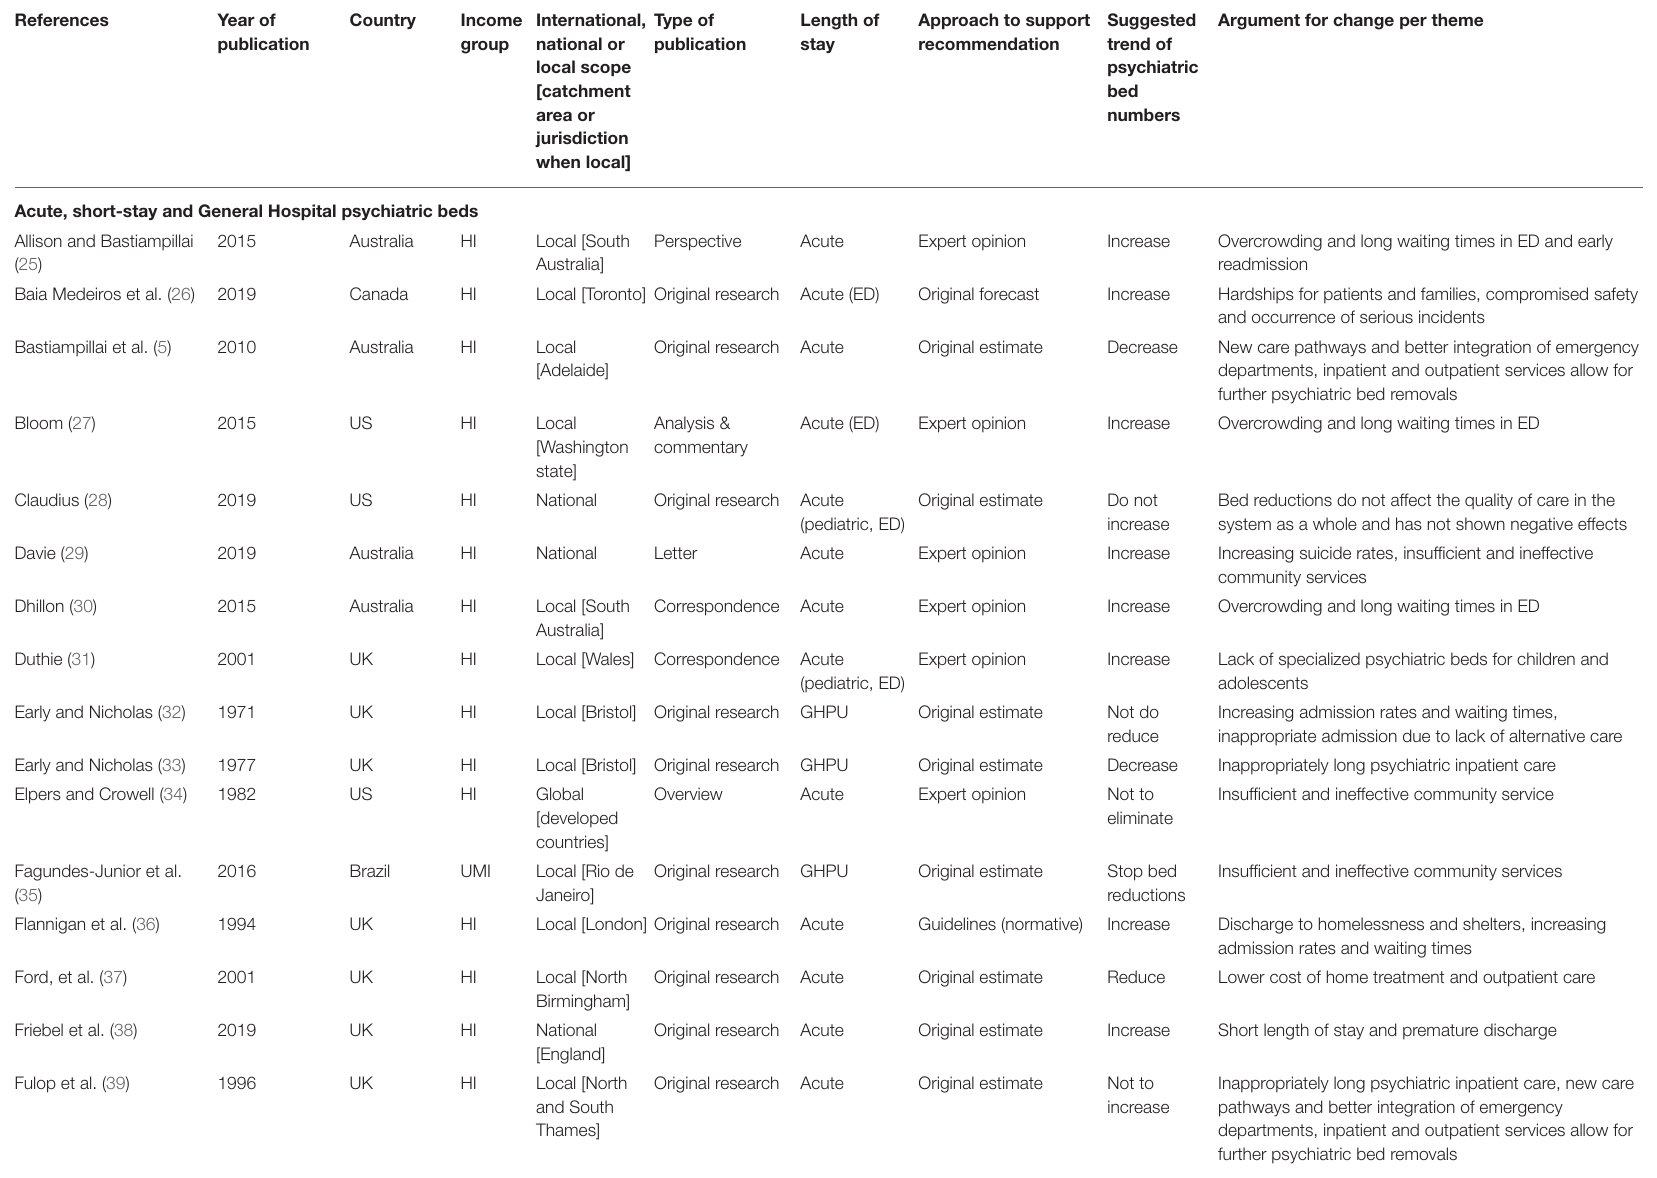
TABLE 1 | Publications reporting recommendations and arguments for trends of psychiatric bed numbers sorted by length of